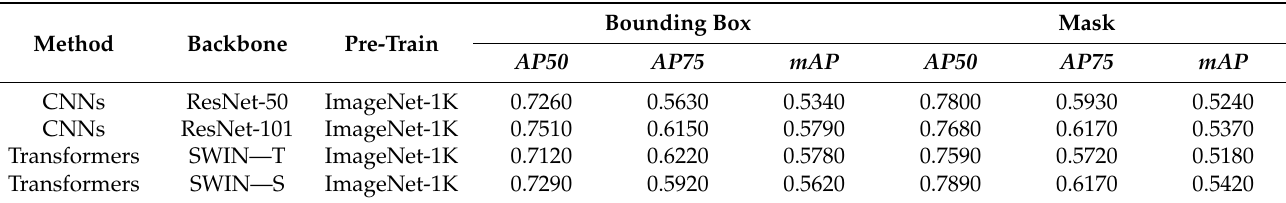
Table 3. Instance segmentation results on the ash tree dataset using Mask2former with different backbones by using mean average precisions ( mAP ) and the threshold average precisions at 50% and 75% ( AP50 and AP75 ,